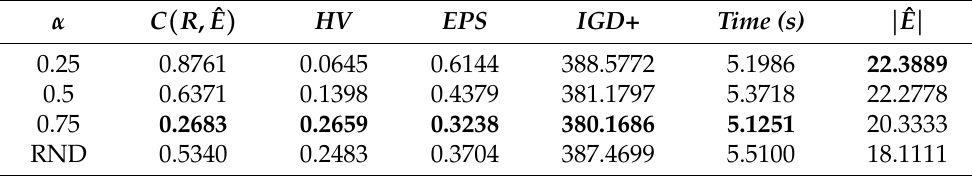
Table 3. Comparison among different α values for the MOFA constructive procedure.